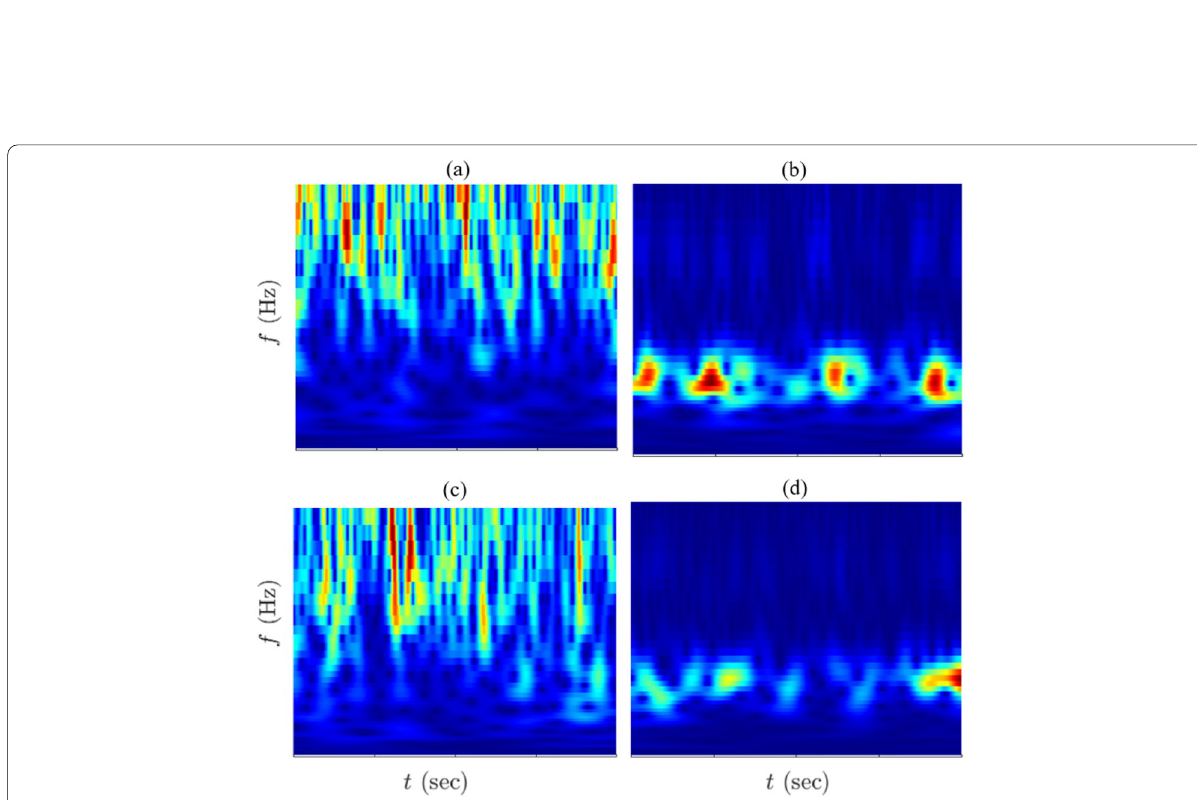
Fig. 10 Spectrograms of IMFs using ( a ) undamaged, ( b ) damaged AE data obtained from A 1 , and ( c ) undamaged, ( d ) damaged AE data from A 2 for damage at